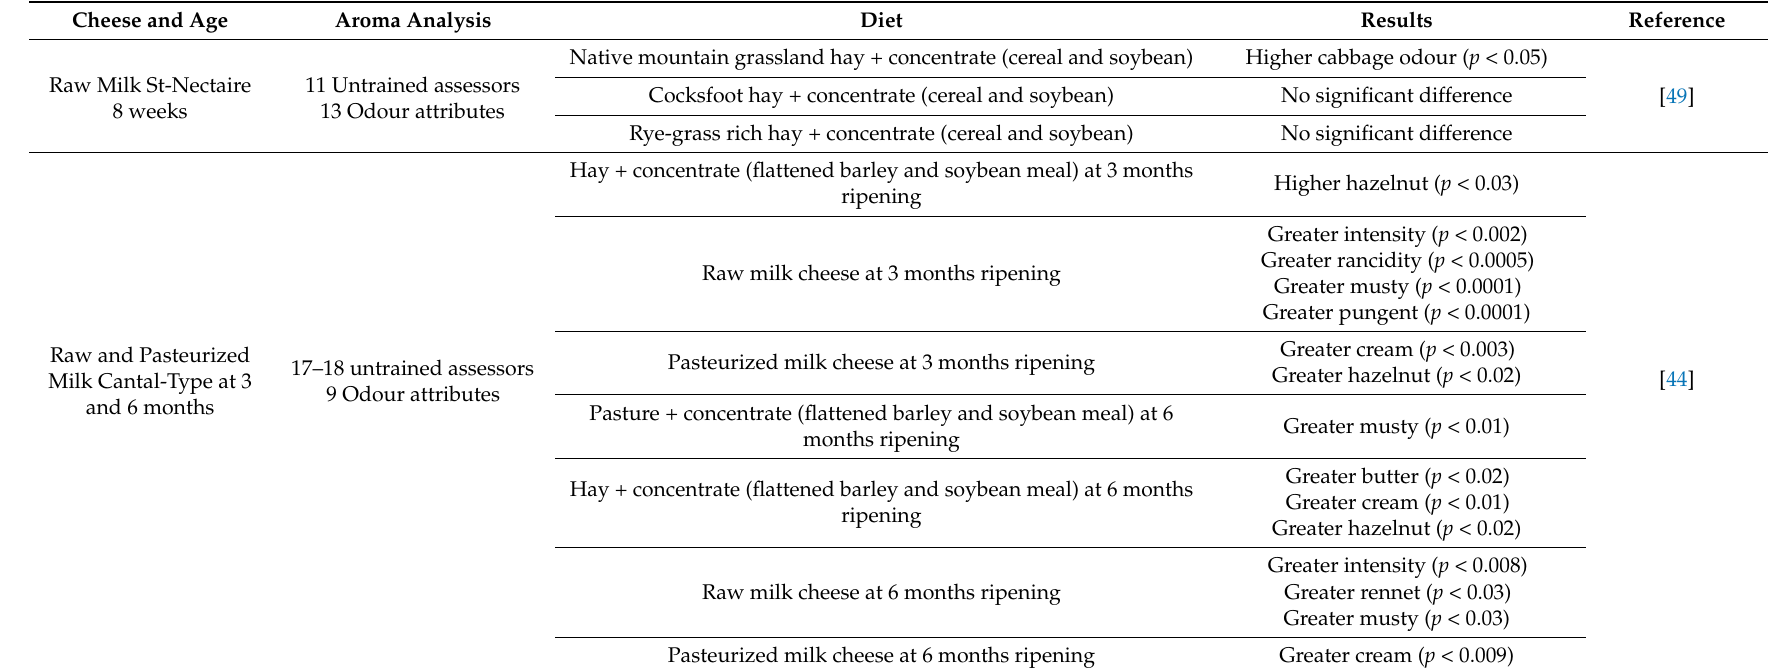
Table 6. Summary of aroma analysis studies on bovine